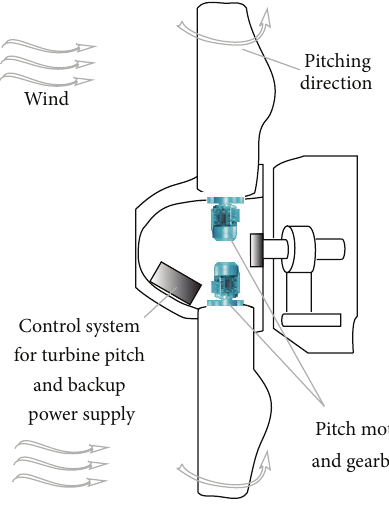
Figure 1: Configuration of pitch regulation subsystem in the WT.